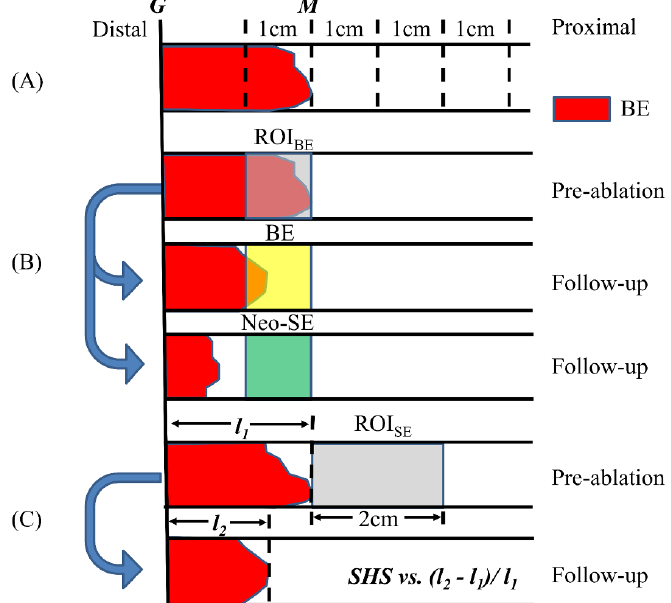
Figure 3. Illustration of the three SHS analysis studies. ( A ) The 4 cm segment starting from the 1 cm Barrett’s esophagus (BE) region distal to M was divided into 1 cm segments to study the general distribution of SHSs. ( B ) The SHSs in the BE region 1 cm segment distal to M were analyzed and metrics were compared to post-ablation response. ( C ) The SHSs in the squamous region were analyzed and metrics were correlated with the relative change of BE length after ablation.